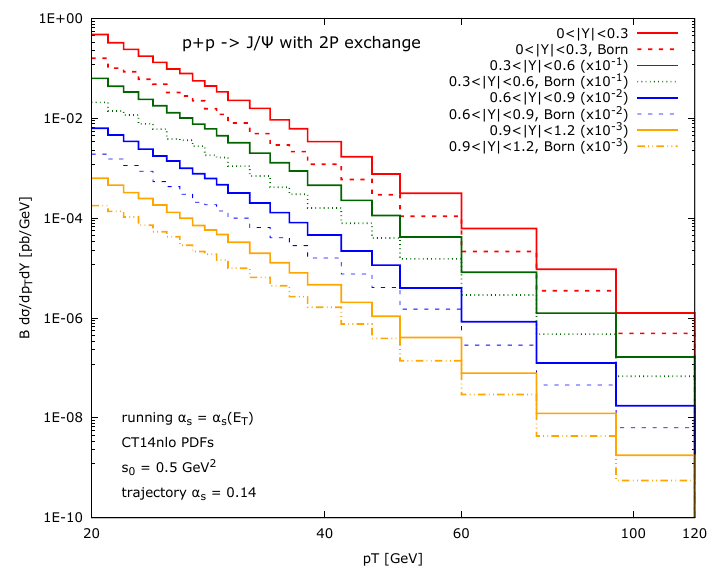
Figure 14 . The same theoretical distributions as in figure 11 but gathered on single plot and compared with the Born-level cross section.